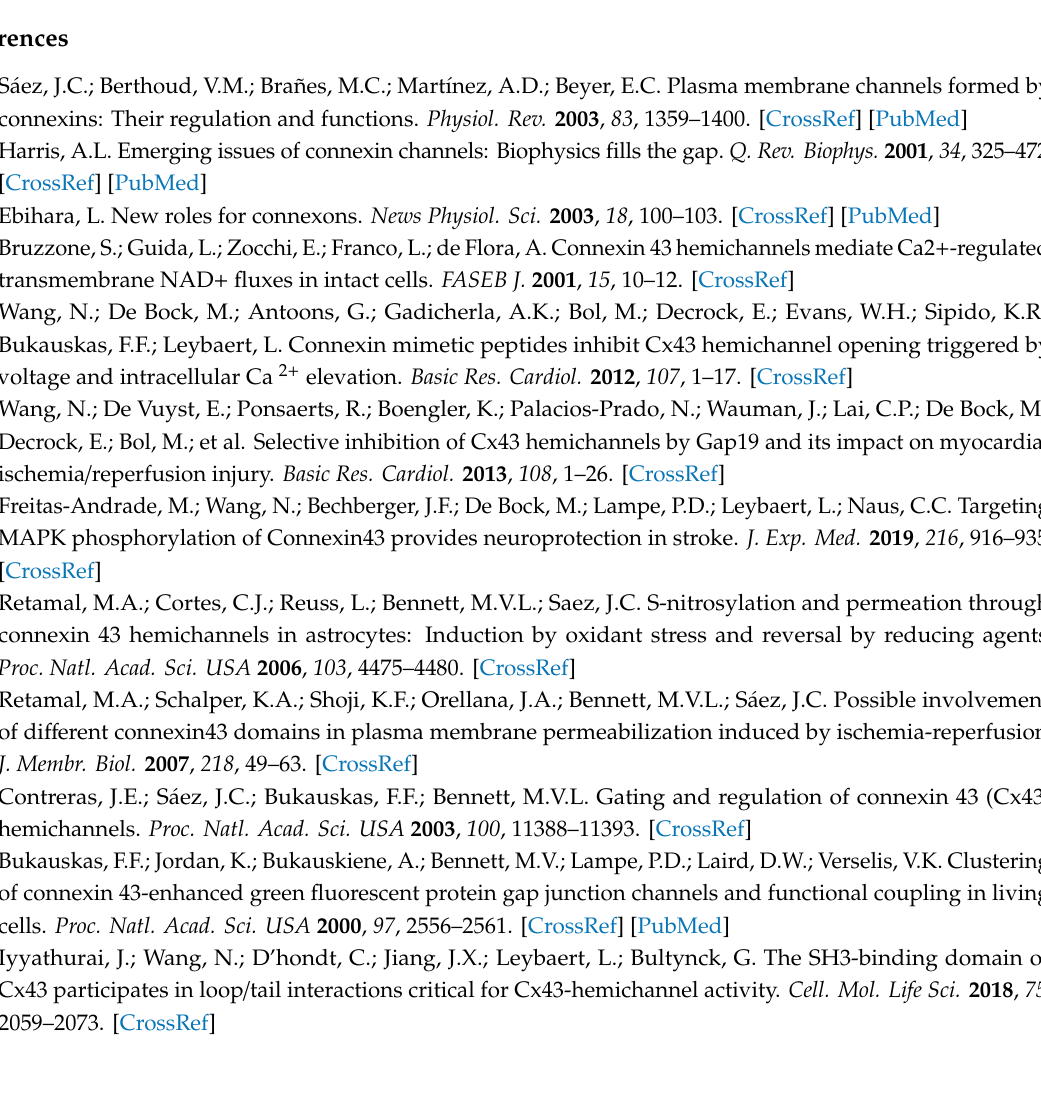
fitting of representative transitions obtained in three experimental conditions. Figure S4. Schematic representation of gating states observed in this